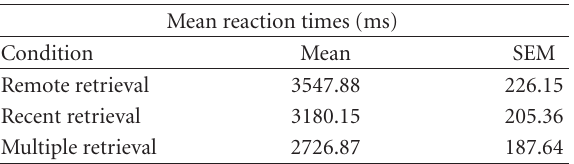
Table 2: Mean reaction times by retrieval condition. While in the scanner, participants responded by mouse button press after read- ing the presented memory cue and orienting to the corresponding memory. Mean reaction times are reported in milliseconds (stan- dard error of mean;